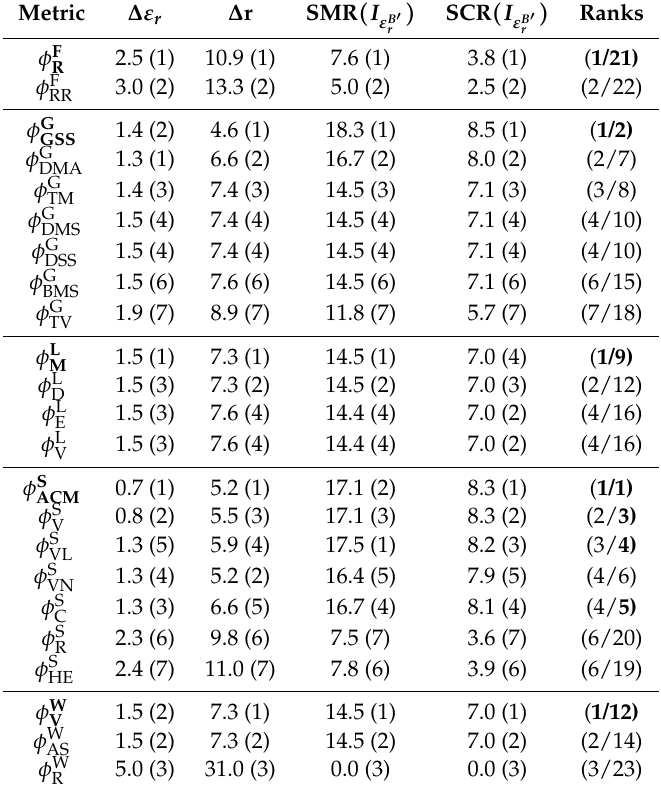
Table 2. Evaluation of performance of all metrics in homogeneous scenarios. Ranks are shown in parentheses, within each method of action for each individual criterion. Two overall ranks are shown, first within each method of action and then for all metrics (local/global). The top performing metrics are shown in bold